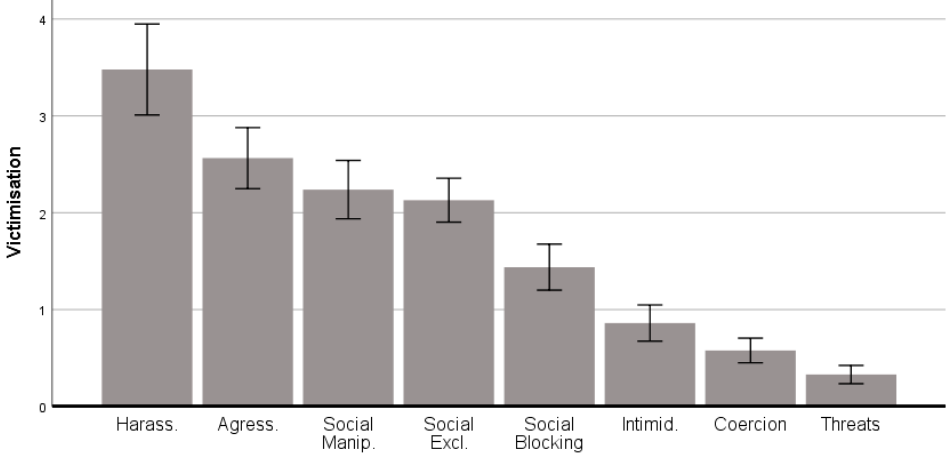
Figure 2. Types of victimization. Error bars 95% CI.